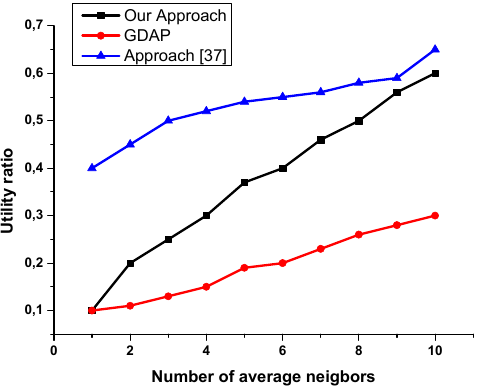
Figure 8. Comparison between the three approaches based on the utility ratio.